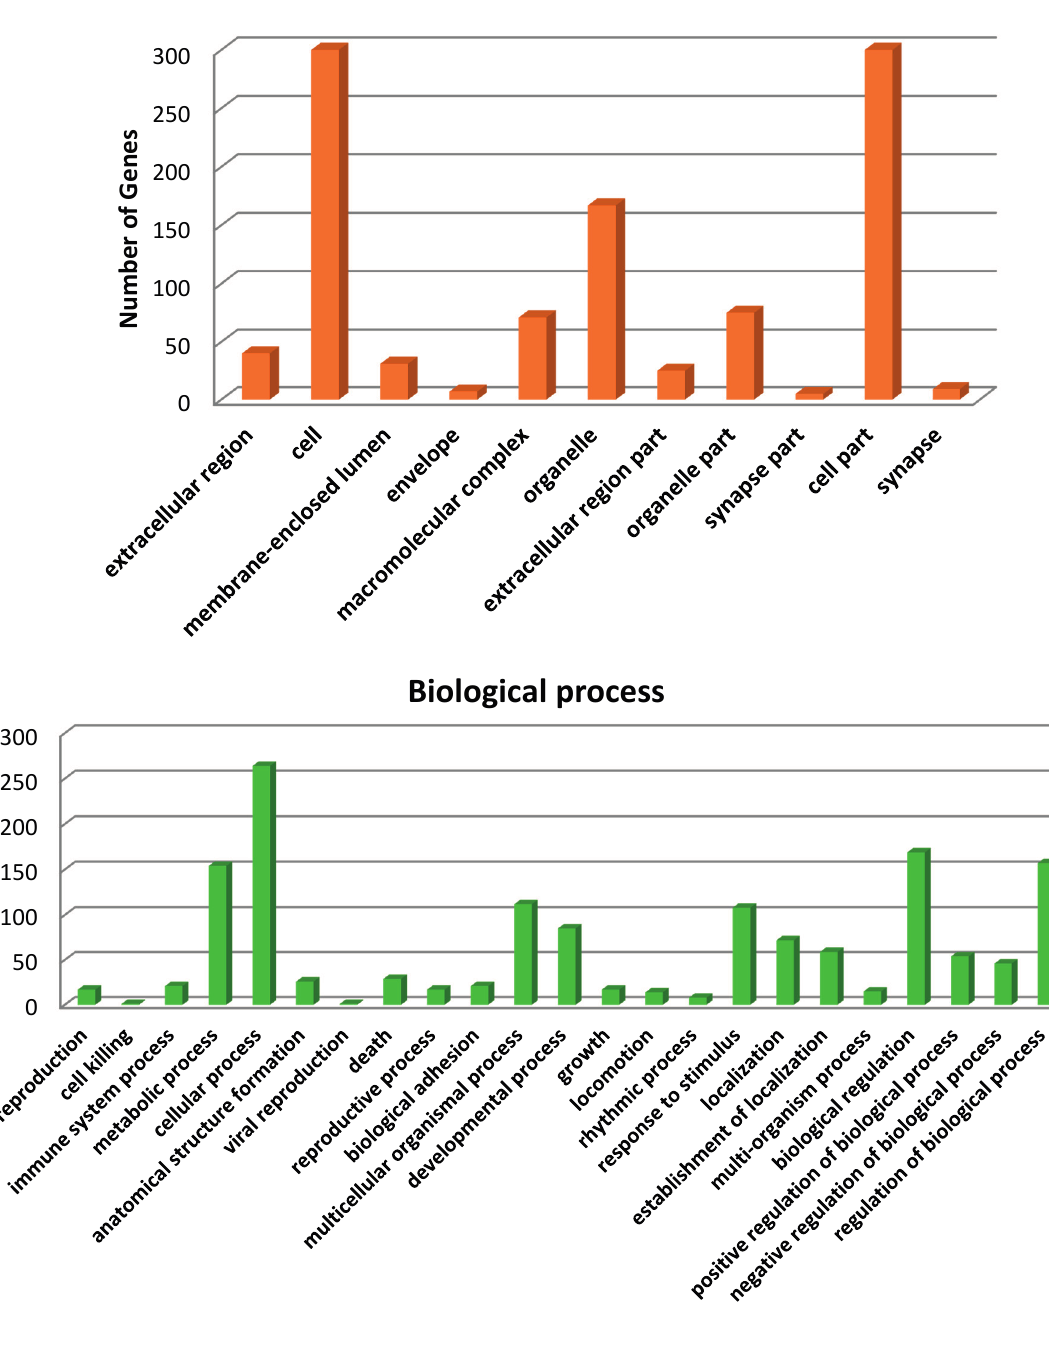
Figure 4. Gene ontology (GO) analysis of 973 genes in which SM-induced alteration of expression was abolished or attenuated by MSTF treatment. These genes of liver tissue were subject to GO analysis using the SBC (Shanghai Biotechnology Corporation) Analysis System (http://sas.ebioservice.com/portal/root/molnet_shbh/index.jsp) and the results summarized in a bar chart showing the number of genes associated with GO terms. GO (Level 2) for the transcriptome under molecular function, cellular component and biological